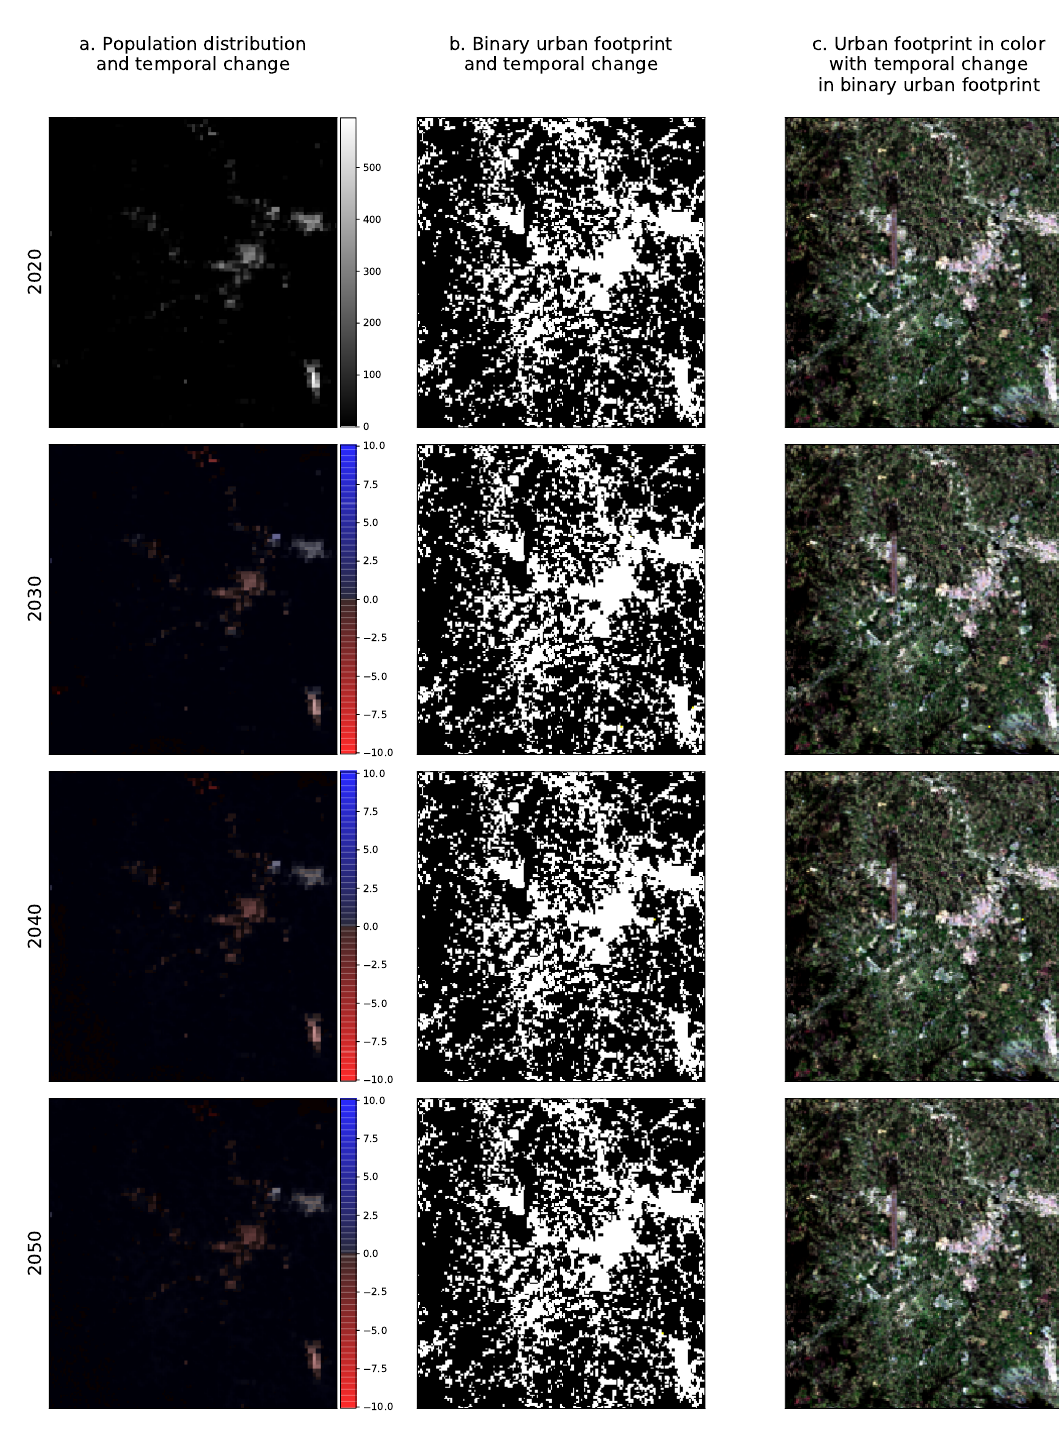
Figure 27. Urban growth predictions in the geographic area of interest that includes Rionegro. It is very interesting to notice that, both in Valledupar and Rionegro, the urban population density changes so much, following different paths but to the same recent trend of lower values. According to the diagnostic graphs, the population density has been reducing drastically in Rionegro as the urban areas are growing much more rapidly than the total population itself. In Valledupar, it rose to a maximum in 2011, and then it decreased again. This trend is in agreement with the findings of [71,72] that reported a trend towards sprawl and low-density growth in some Latin American cities in recent